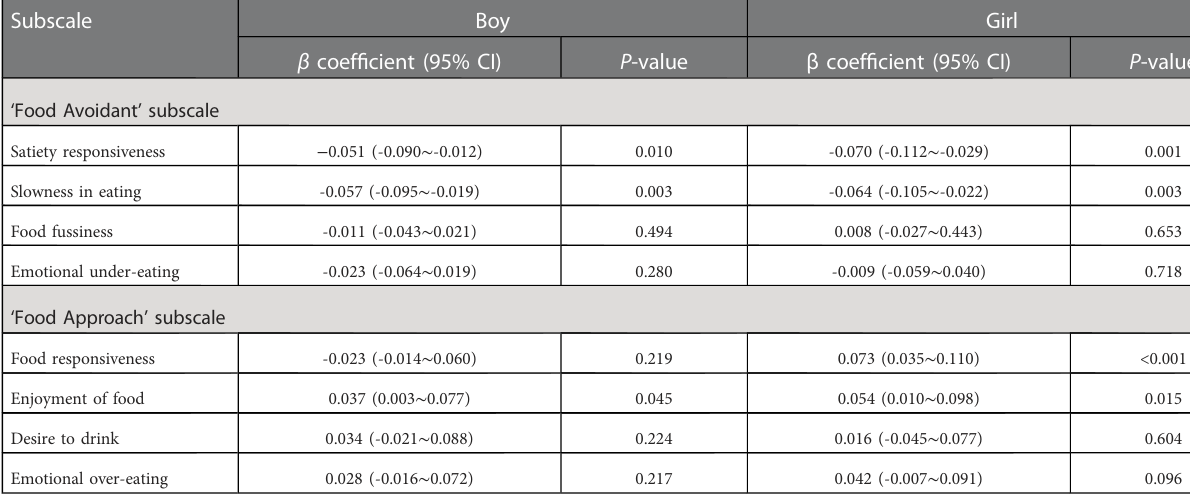
TABLE 4 Linear regression analyses for children ’ s BMIZ on CEBQ subscales ( N =1935). Subscale